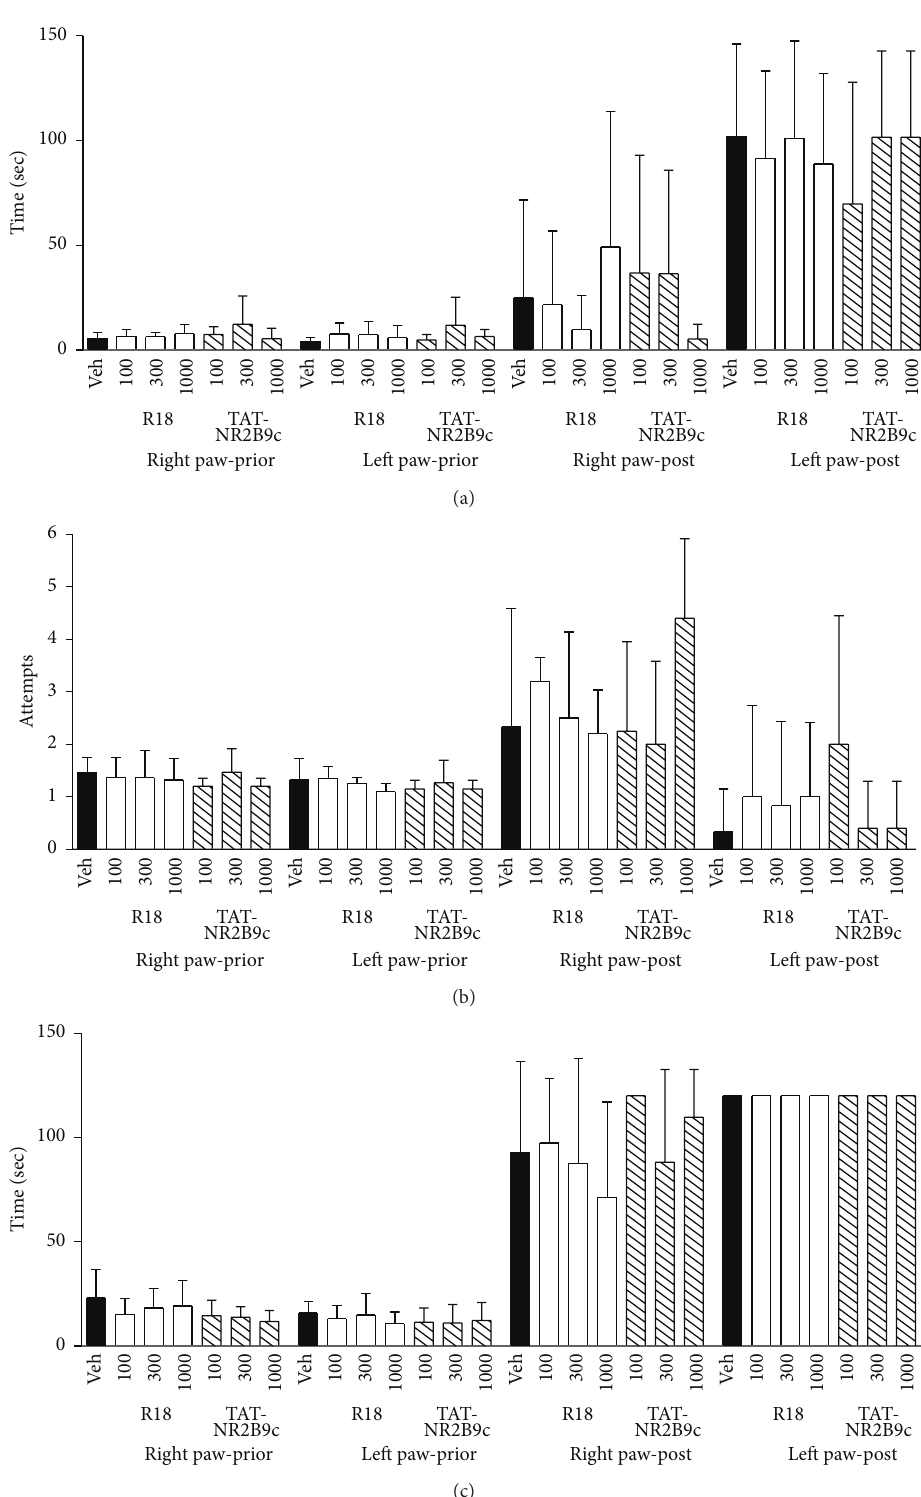
Figure 3: Functional assessment measurements using adhesive tape removal test before and 24 hours after MCAO for saline (vehicle) and peptide (R18 and TAT-NR2B9c at 100, 300, or 1000nmol/kg) treatment groups. (a) Time to detect tape. (b) Number of attempts to remove tape. (c) Time to remove tape. Values are mean ± SD. Maximum time allowed for adhesive tape removal was 120